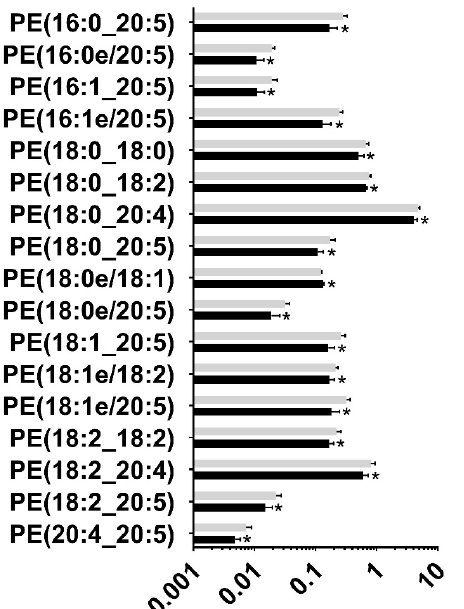
Figure 3. Significantly altered Phosphatidylethanolamine subspecies in the maternal blood following gestational alcohol exposure. Targeted analysis of Phosphatidylethanolamine (PE) was performed to identify PE levels in rat maternal blood following alcohol consumption during pregnancy. Seventeen subspecies were significantly altered ( p < 0.05) in maternal blood of the alcohol-administered rat, of which 16 were downregulated and 1 was upregulated (PE 18:0e/18:1). *, p < 0.05.